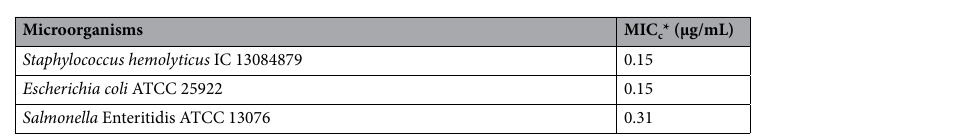
Table 6. MIC of chloramphenicol, with the initial concentration of 20 µg/mL. *MICc = Minimum inhibitory concentration of chloramphenicol.